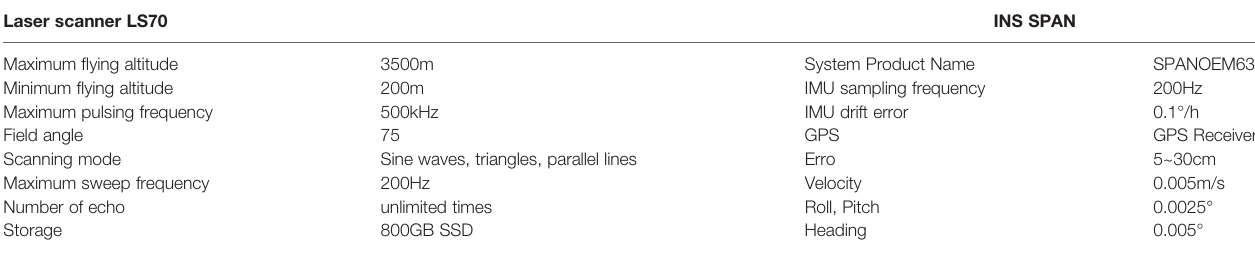
TABLE 1 | Main technical parameters of Airborne LiDAR scanning system.